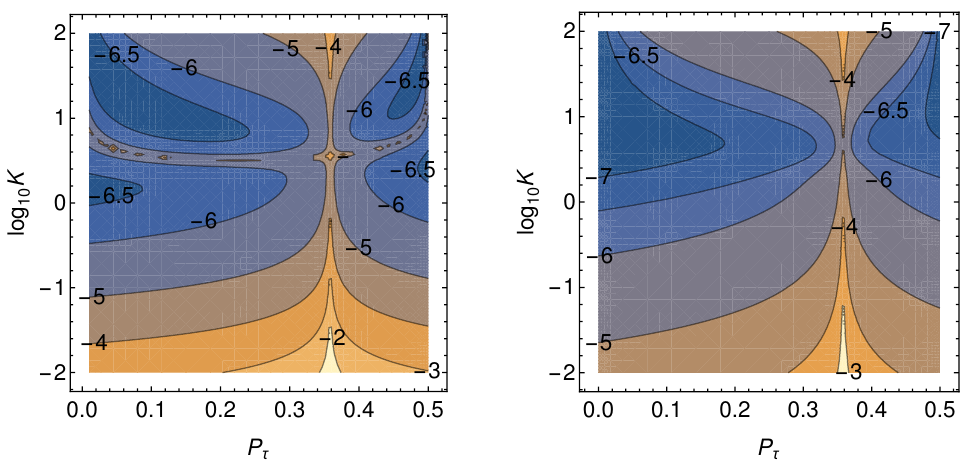
Figure 3 . Required log j (cid:14)(cid:15) j for the purely (cid:13)avored case (cid:14)(cid:15) e = (cid:0) (cid:14)(cid:15) for zero (left) and thermal 10 (right) initial N 1 abundance to explain the observed baryon